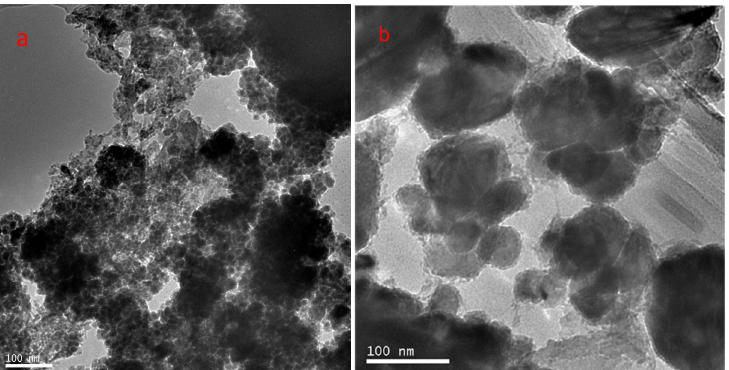
Figure 6. TEM photos of the products with different reaction times ( a ) 0.5 h; ( b ) 2 h.